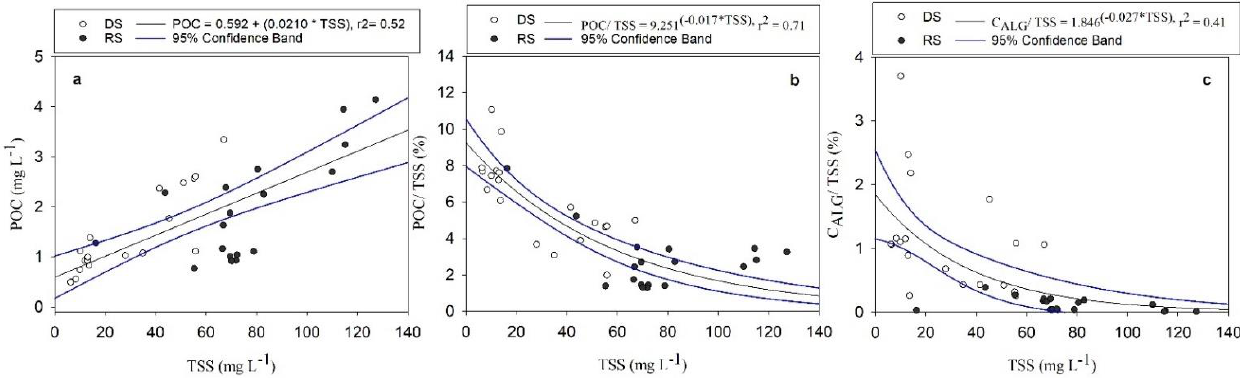
Figure 3. Variation in the organic carbon contribution to the total suspended solids in the Usumacinta River during the dry (DS) and rainy (RS) seasons: ( a ) relationship between the POC and TSS concentrations, ( b ) relative content of POC in TSS as a function of the TSS concentration, and ( c ) relative contribution of C ALG to TSS as a function of the TSS concentration.